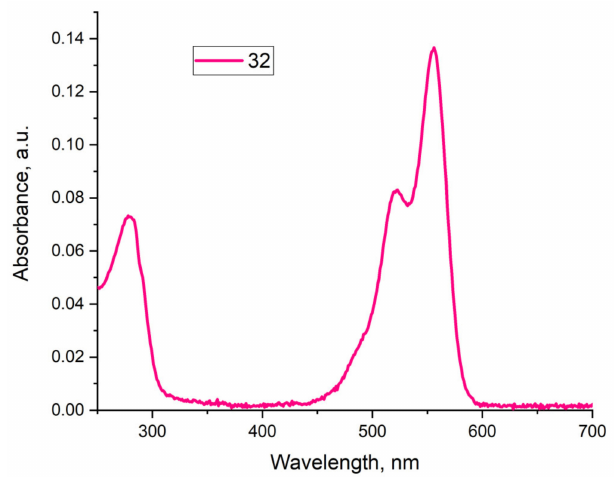
Figure 5. UV/Vis absorbance spectrum of conjugate 32 .